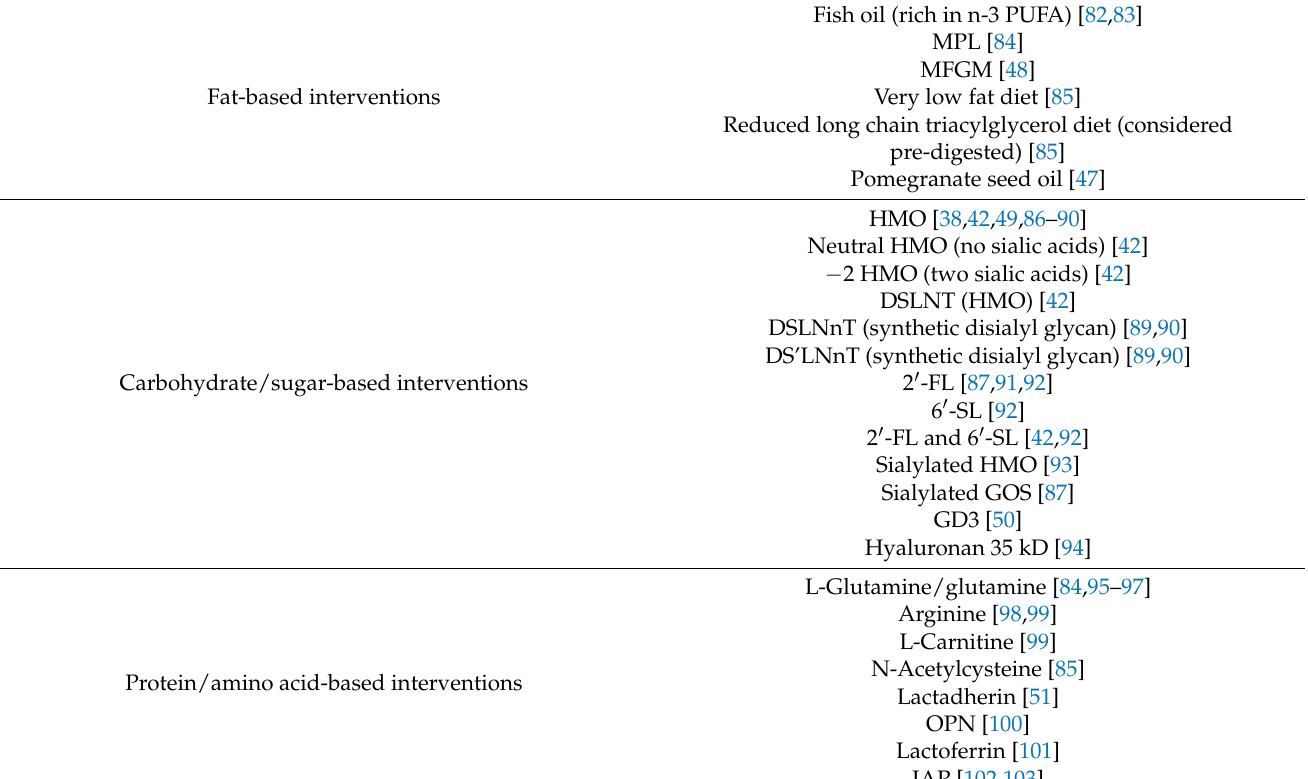
Table 2. Enteral feeding interventions improving histological injury scores in experimental animal models of